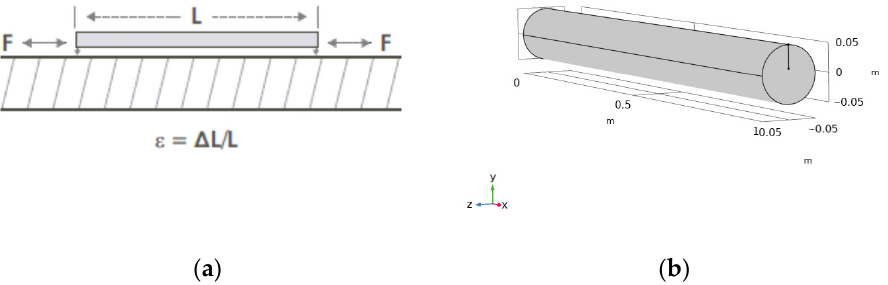
Figure 5. Simulation results of the 3D duct model in COMSOL: ( a ) real part of the pressure field in Pascal and ( b ) amplitude of the pressure field at f = 1000 Hz in Pascal.